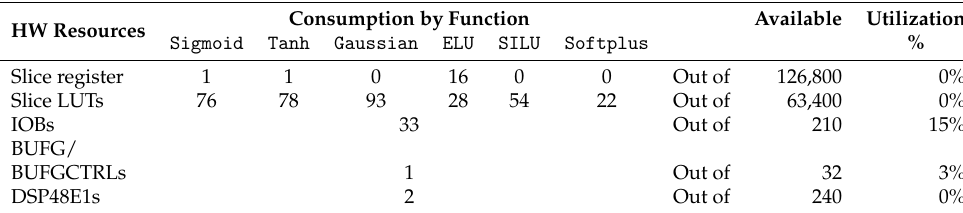
Table 14. Hardware resource usage for the PPA-ED-based AFCs.